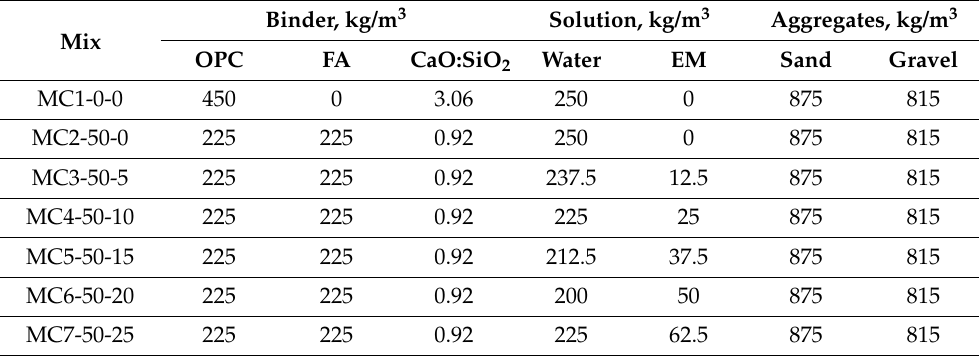
Table 3. Modified concrete mix design containing different amount of